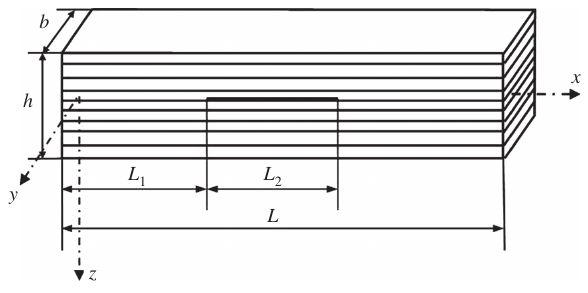
Figure 1 A schematic of generally LCB with single delamination.